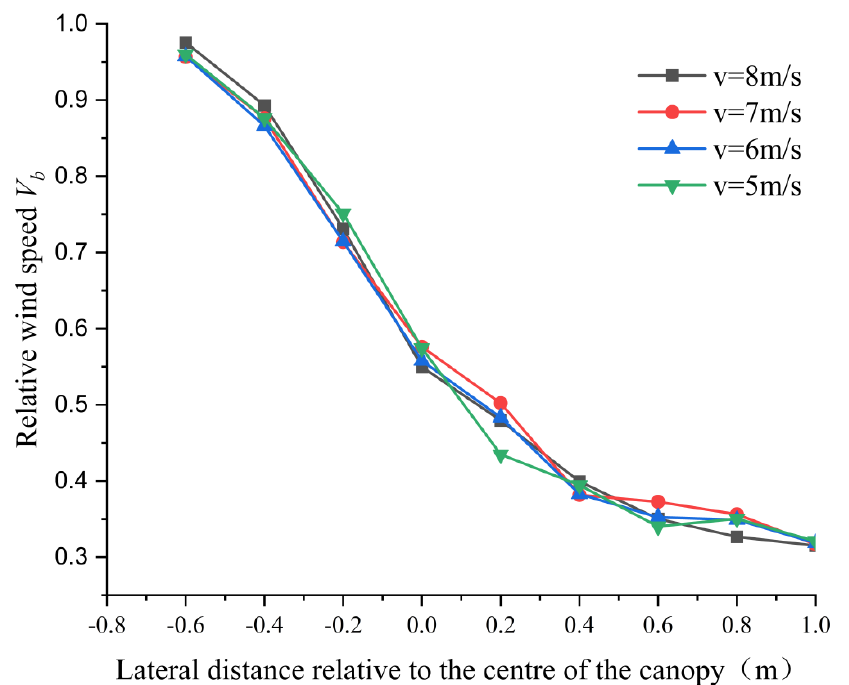
Figure 9. Relative wind speed in front of and behind the centre of the canopy of tree 5.